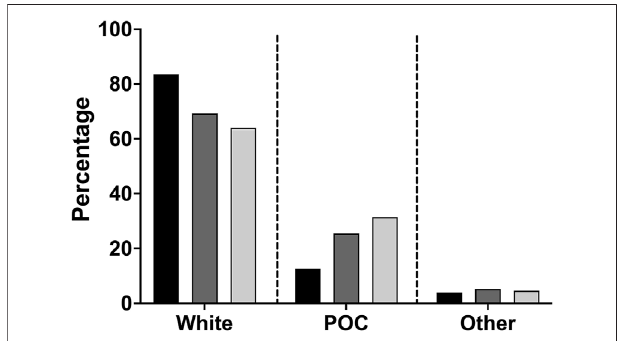
FIGURE 3 | Demographic composition of SABER 2020 conference attendees. Black bars represent individuals who had attended fi ve or more SABERconferencesasof2020.Darkgreybarsrepresentindividualswhohad attended two to four SABER conferences as of 2020. Light grey bars represent fi rst-time SABER